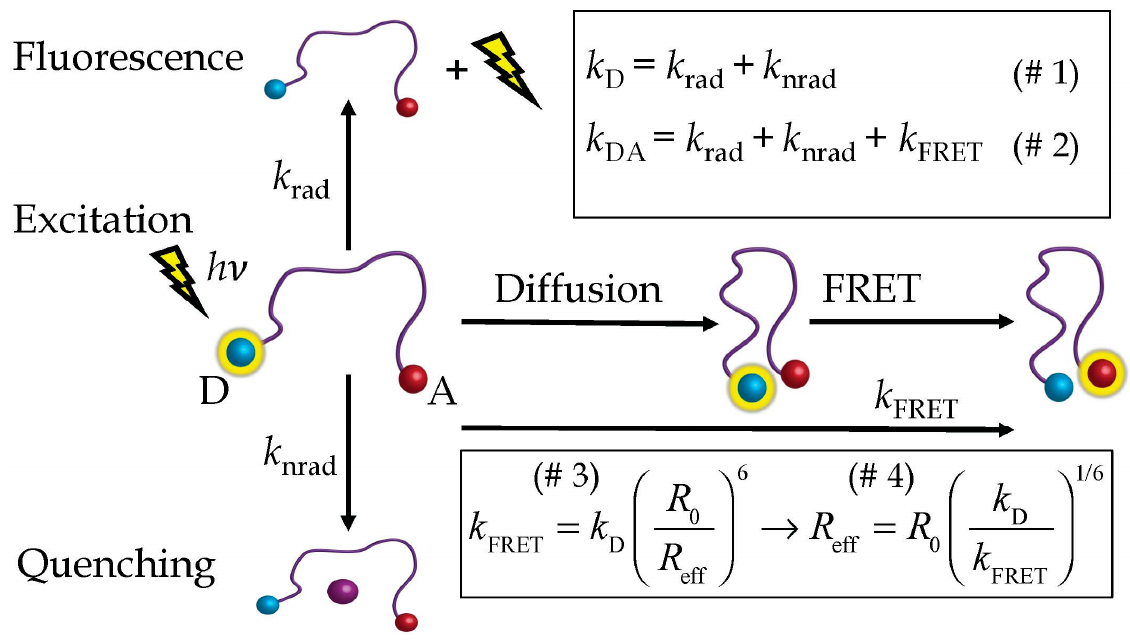
Figure 1. DFRET: Diffusion-enhanced Förster resonance energy transfer. After excitation, the excited donor, D, can either become deactivated by emitting fluorescence ( k rad ) or by being quenched, for instance, by iodine ions ( k nrad ) or by transferring its excitation energy to the acceptor, A ( k FRET ). FRET can take place at every D-A distance but is more likely to happen at shorter distances, which is why it is enhanced by D-A diffusion. The pertinent equations (I–IV) are explained in the main text.